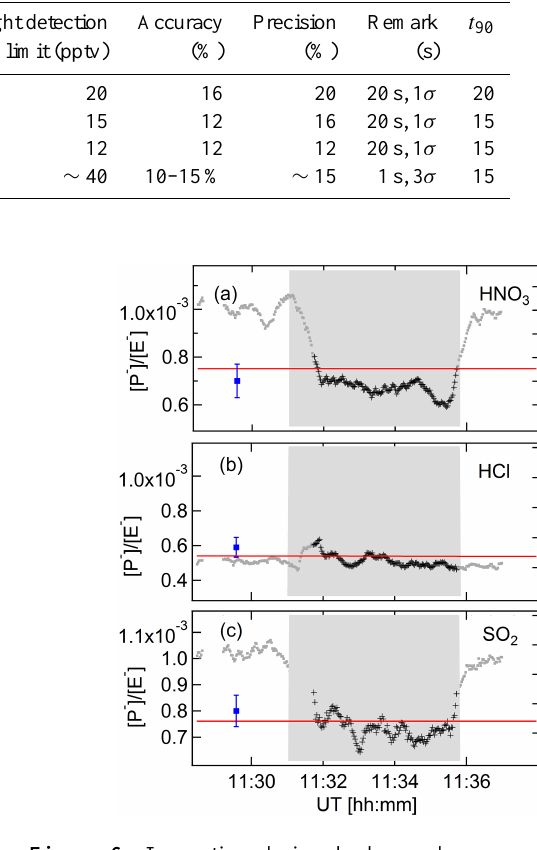
Figure 6. Ion ratios during background measurements for (a) HNO 3 , (b) HCl and (c) SO 2 in tropospheric air during the flight on 11 September 2012 at 11:31UT. Gray shaded areas show se- quences where synthetic air was introduced. The red curves repre- sent the values applied to correct for the instrumental background during atmospheric measurements. Except for the first hour of the flight, the background can be described by a constant value of 0 . 75 × 10 − 3 for HNO 3 , 0 . 54 × 10 − 3 for HCl and 0 . 8 × 10 − 3 for SO 2 . For comparison, the ion ratio averages inferred during laboratory measurements are given (blue squares). Generally, in-flight-based and ground-based measurements agree within the given variability of the laboratory and flight